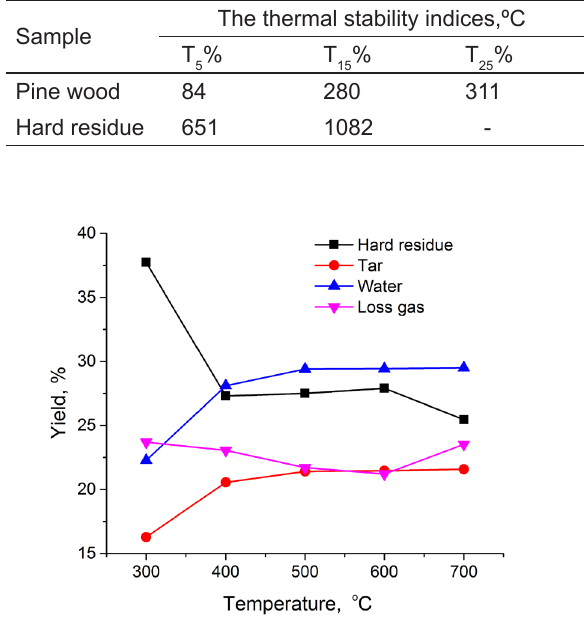
Fig. 7. The yields of solid, liquid and gas products of pyrolysis of pine